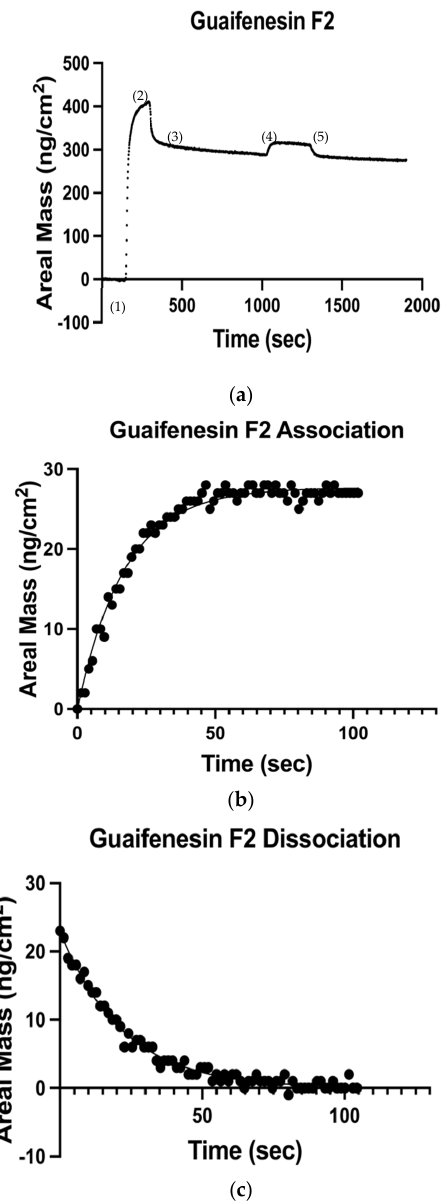
Figure 1. ( a ) Representative run of a mass converted QCM binding curve for guaifenesin. The baseline interval (1), represents pure buffer rinse on the crystal surface. Interval (2) represents the addition of HSA onto the crystal surface; (3) buffer rinse to wash off incompletely bound protein; (4) addition of guaifenesin; (5) PBS buffer rinse. The binding and unbinding kinetics for regions 4 and 5 are displayed in ( b , c ), respectively.